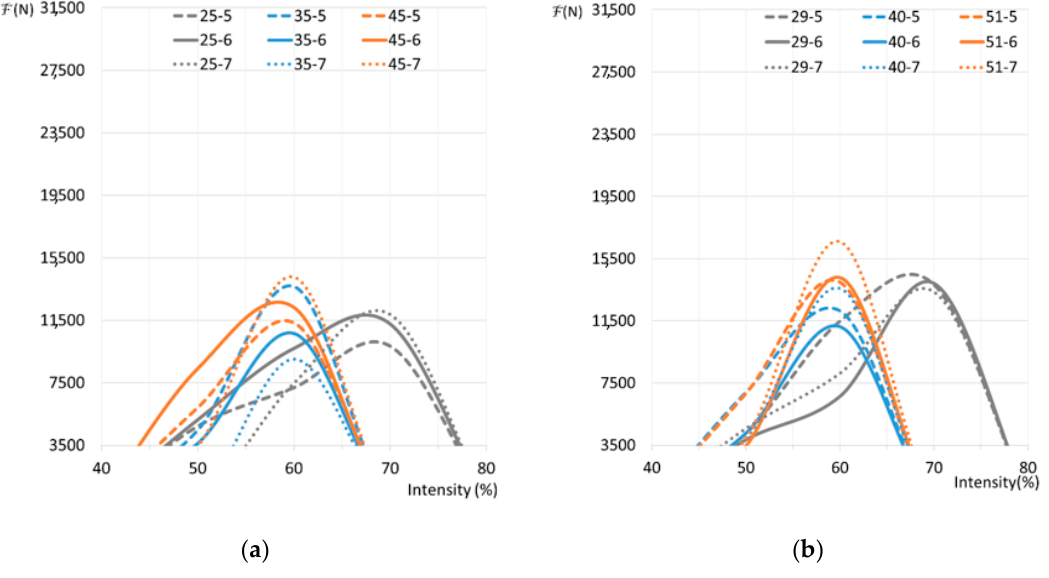
Figure 10. Force necessary for failure. Weld thickness: 16 mm ( a ) and 18 mm ( b ).